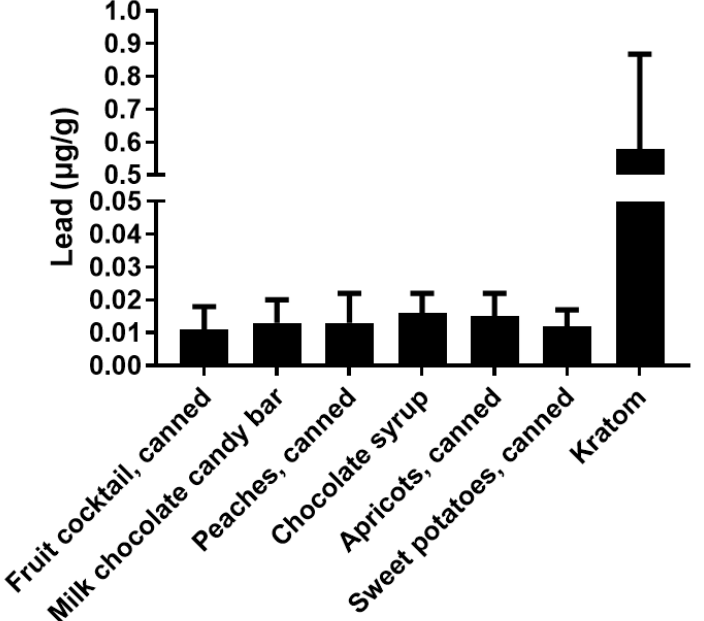
Figure 2. A comparison of the levels of Pb in various foods and kratom. The results show the mean ± SD for levels of Pb ( µ g/g) from various foods and kratom. The kratom data were obtained from the FDA (2019). Data for the other materials were obtained from the FDA Total Diet Study.